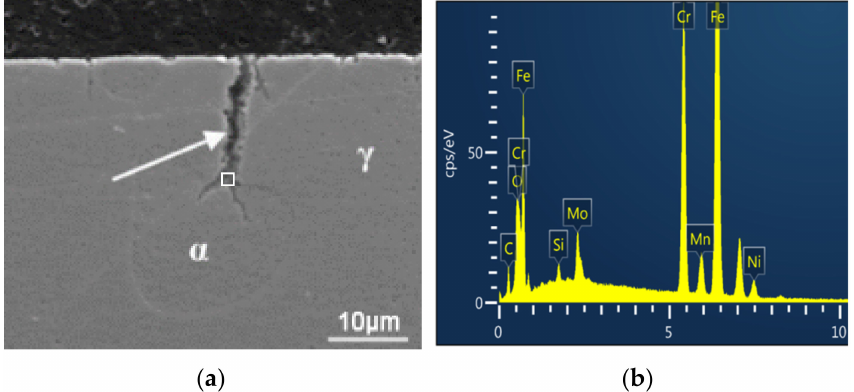
Figure 9. Cross-section morphology of secondary cracks ( a ) and the EDS analysis of corrosion products accumulated at the crack ( b